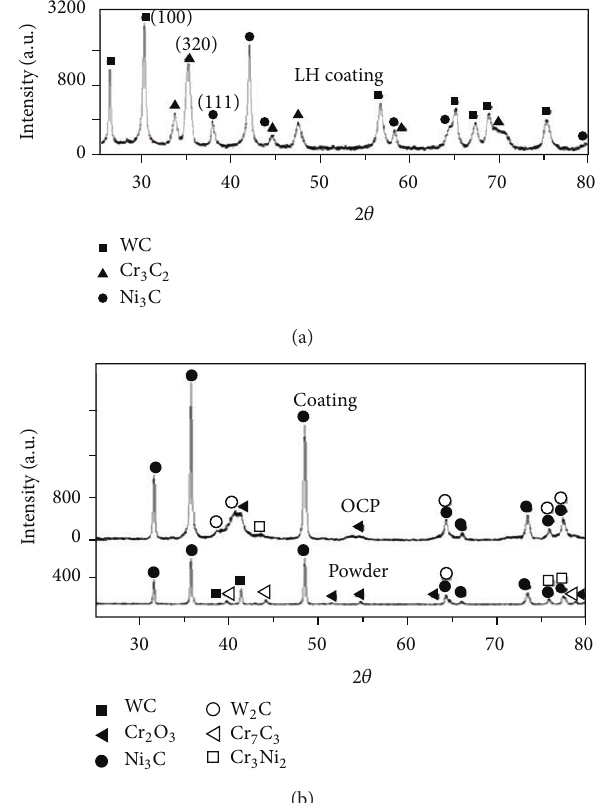
Figure 2: Crystalline phases of powder, coating, and LH coating.